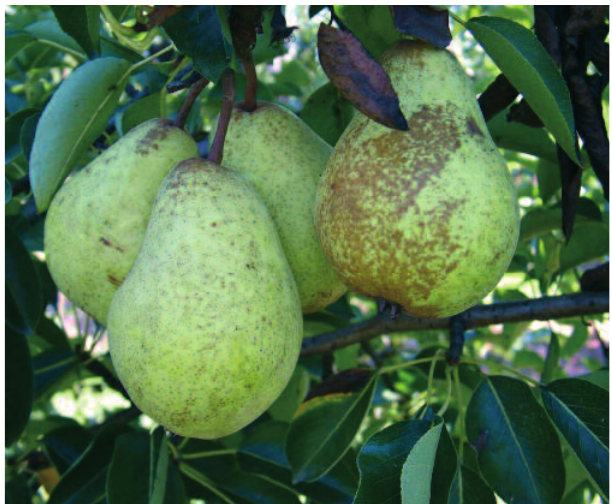
Figure 1: Williams pear at